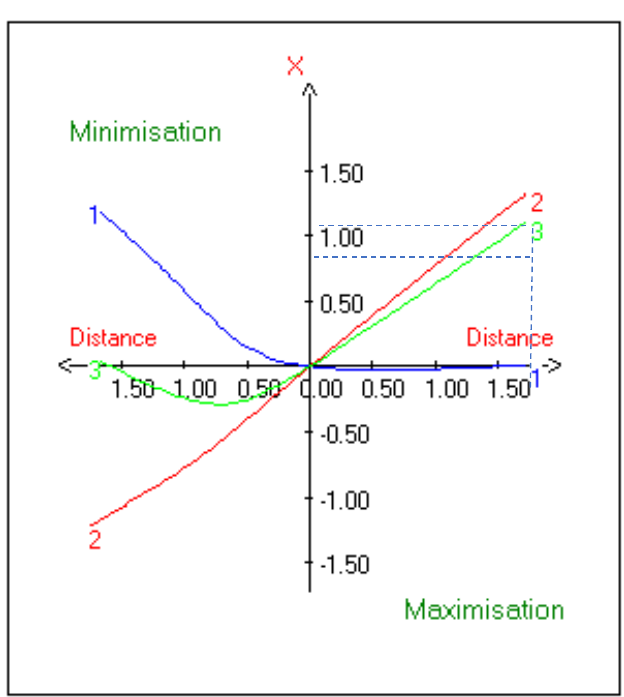
Figure 9. Distance-coded variable.